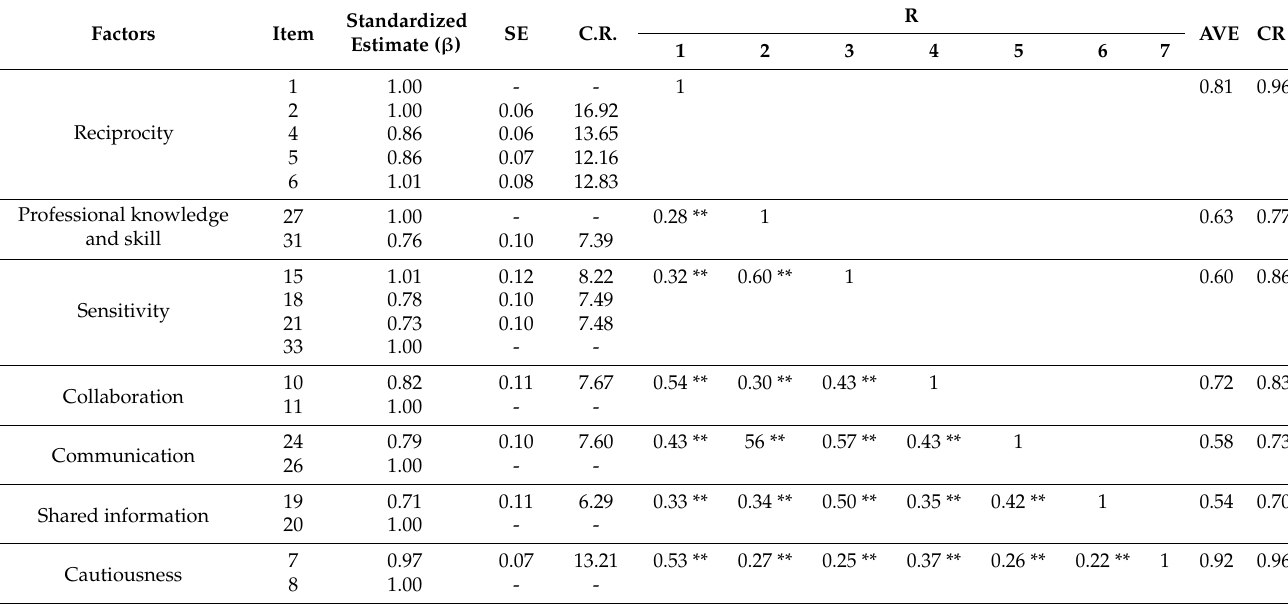
Table 3. Results of the Final Model of the